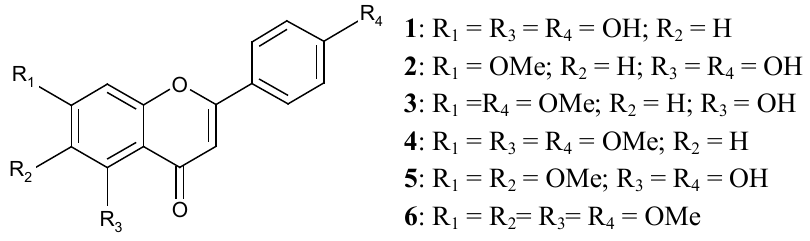
Figure 1. Isolated flavonoids from Praxelis clematidea .